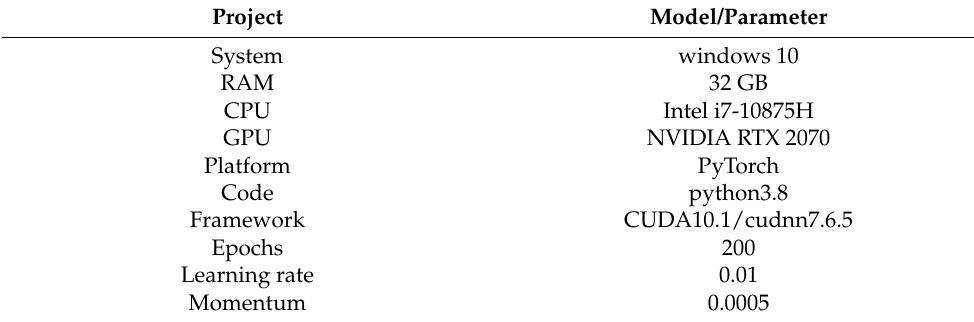
Table 2. Experimental setup and